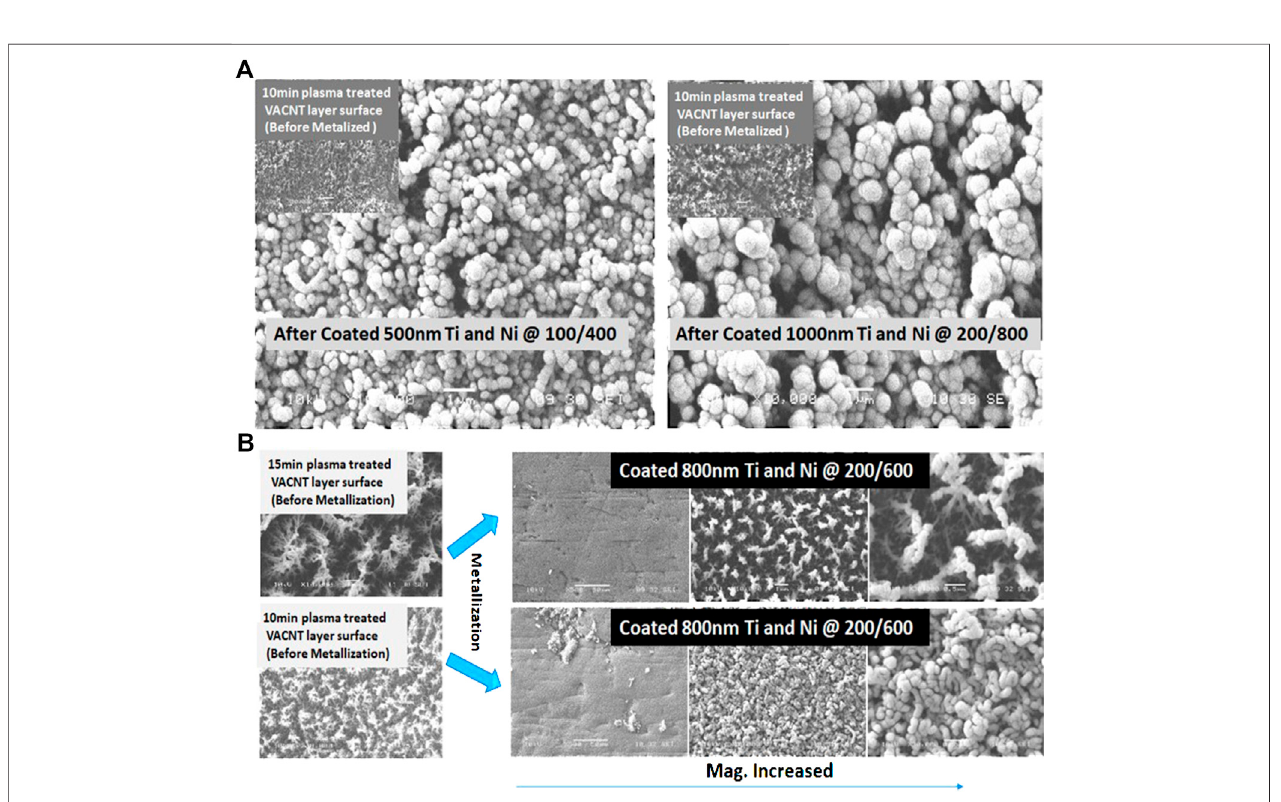
FIGURE8| TopviewSEMImages. (A) Thebi-metallayerwithdifferentthicknesscoatedonPlasmatreatedVACNTssurface(10 min). (B) Thebi-metallayercoated on Plasma treated (10 and 15 min) VACNTs surface. Scale bar (cid:2) 1 µm (A) ; Scale bar (from left to right) (cid:2) 1, 50, 1.0, 0.5 µm (B) .